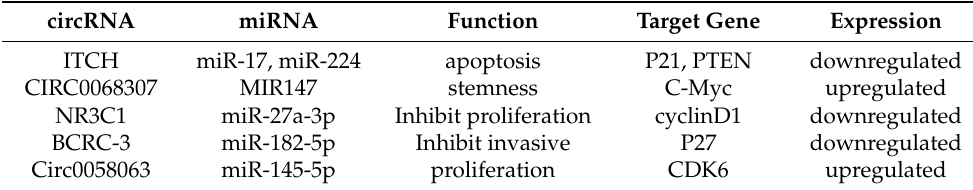
Table 5. The most promising circRNA